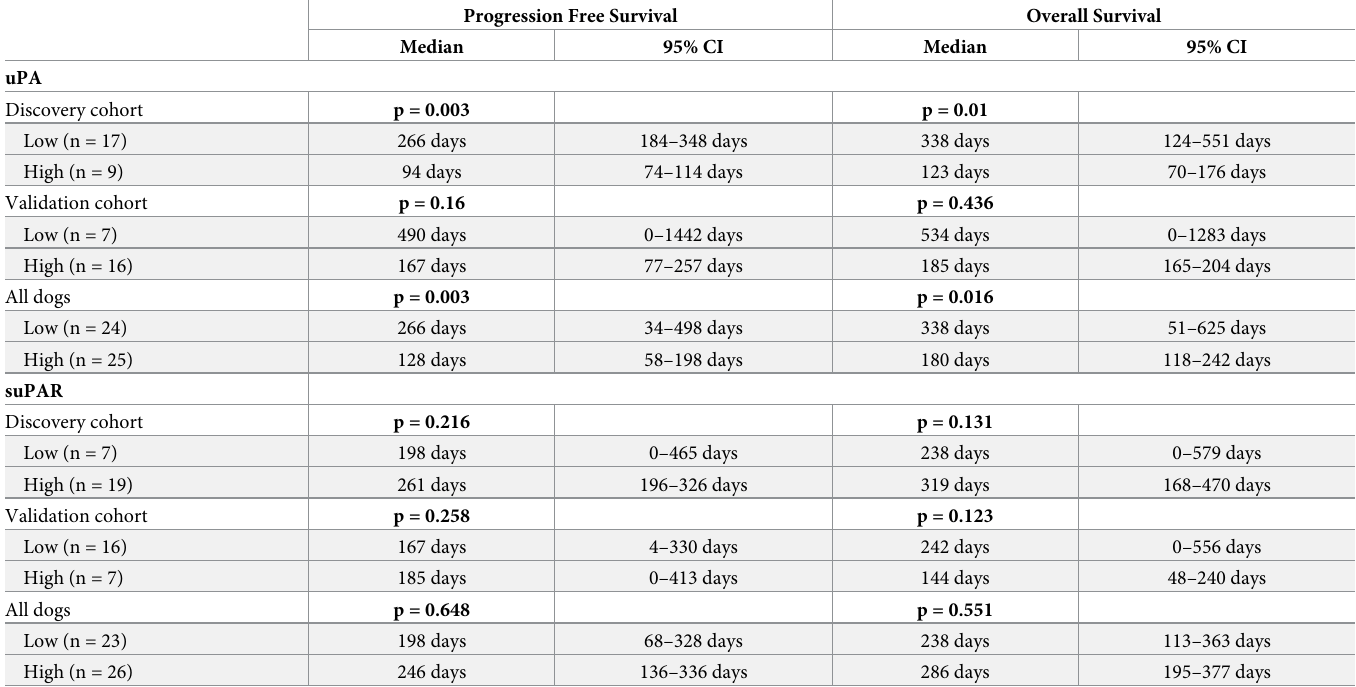
Table 2. Survival of osteosarcoma-bearing dogs with low or high serum uPA and suPAR